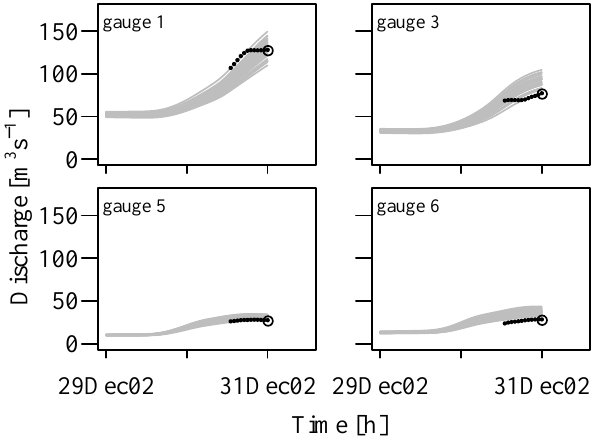
Figure 4. Discharge ensemble forecasts (grey lines) and observa- tions (points) at four locations (gauges 1, 3, 5, 6; see Fig. 2). Obser- vations being assimilated using the AEnKF are schematized accord- ing to the state augmentation size for two scenarios: assimilation of data from the current time step W = 0 (open circle, traditional EnKF approach) and assimilation of data including the previous 11 time steps, W = 11 (black dots). The observations are assimilated into the model states on 31 December 2002,